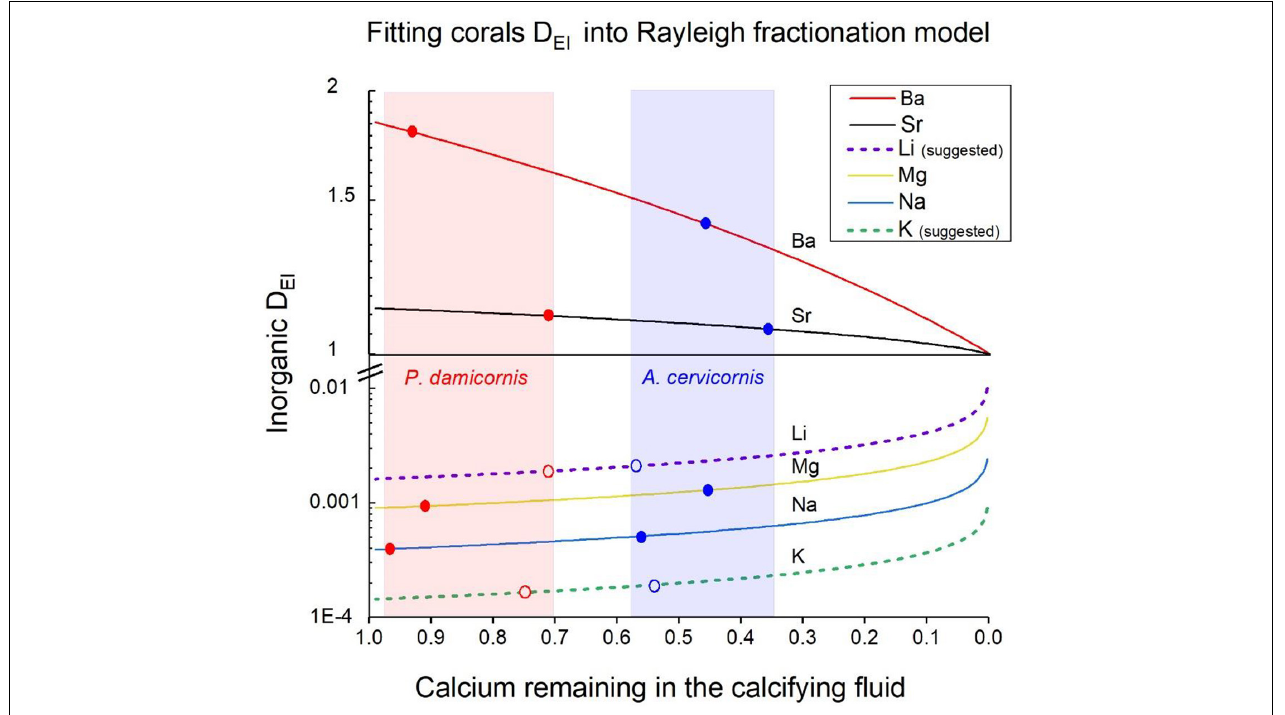
FIGURE 5 | Fitting corals D El values into a Rayleigh model for the calcifying fluid. Inorganic D El values for aragonite precipitating from SW are the starting points of the curves on the Y axis. The solid and dotted lines show the evolution of coral D El precipitating from a closed reservoir (the ECF) for all elements. As Ca is depleted from the ECF elements with D > 1 decrease relative to Ca while elements with D < 1 increase their concentration relative to Ca and D El change accordingly. The Ca depletion is given by the f values ( f = Cainitial /Cafinal). The blue dots are the D El values for A. cervicornis and the red ones for P. damicornis . The shaded areas in light blue and red show the range of f values for these corals, respectively. Note that for Li and K we used D El values marked with open dots as explained in the